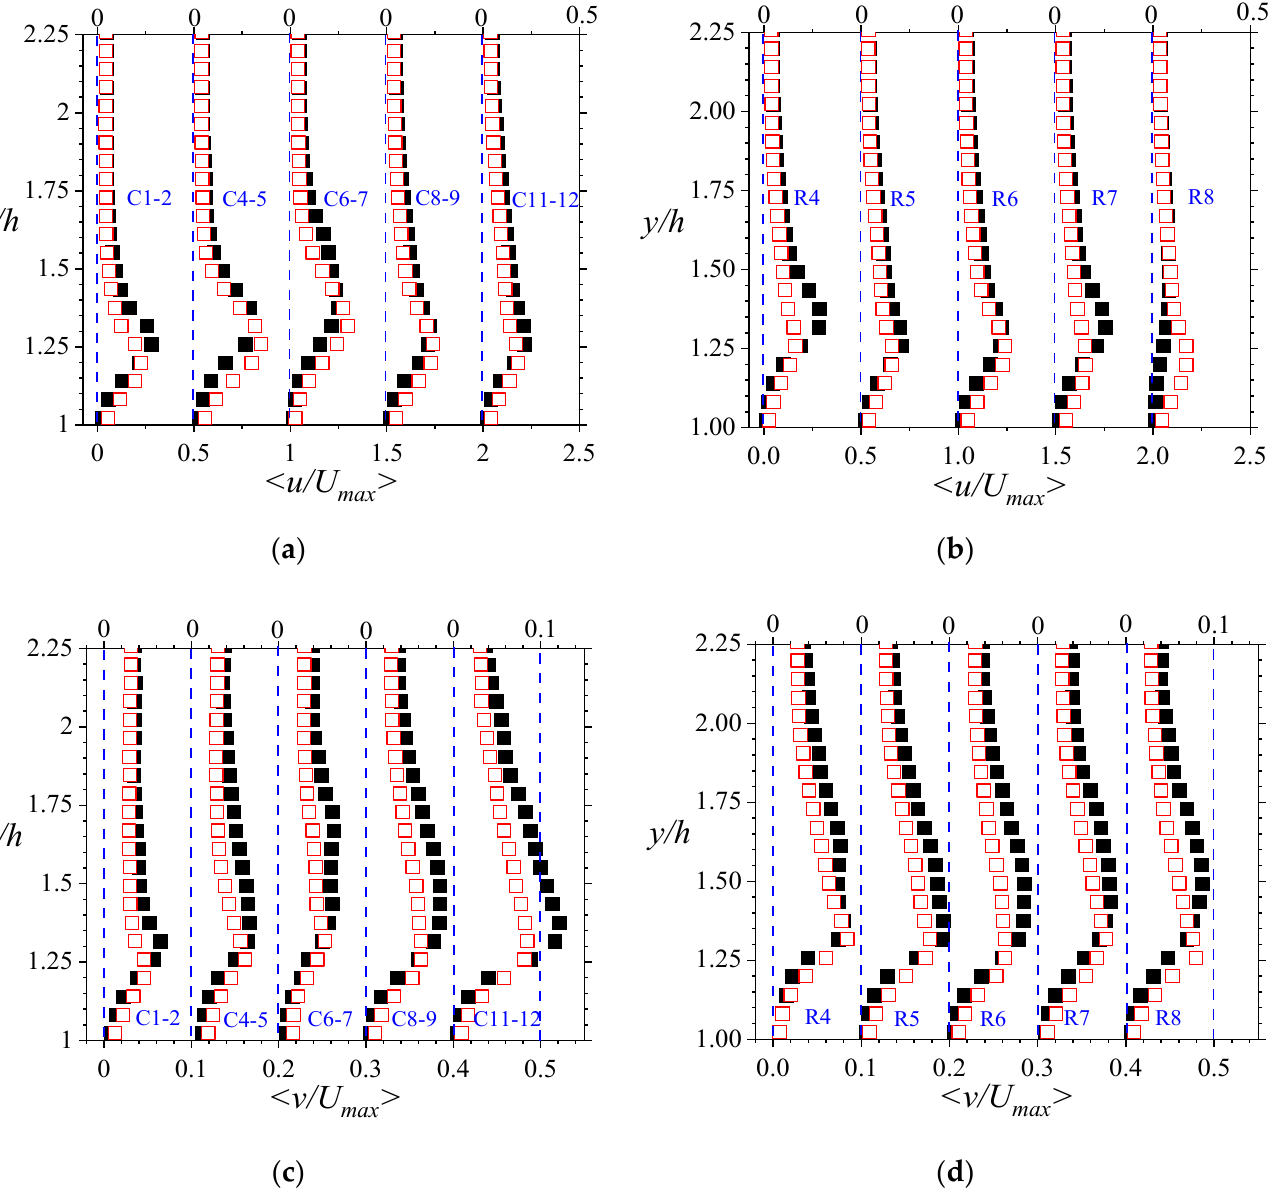
Figure 15. Parameters < u/U max > and < v/U max > are respectively line-averaged streamwise and wall-normal turbulence intensities normalized by the local maximum line-averaged streamwise mean velocity in both open and porous regions. Here, the profiles for the flow in the open region are shown. Staggered plots ( a , c ) show the streamwise variations whereas ( b , d ) demonstrate the spanwise variations. The denominations C and R respectively stand for columns and rows, and are illustrated in Figure 1. Black-filled boxes are the results for Test A , and red-open boxes are the results for Test B .